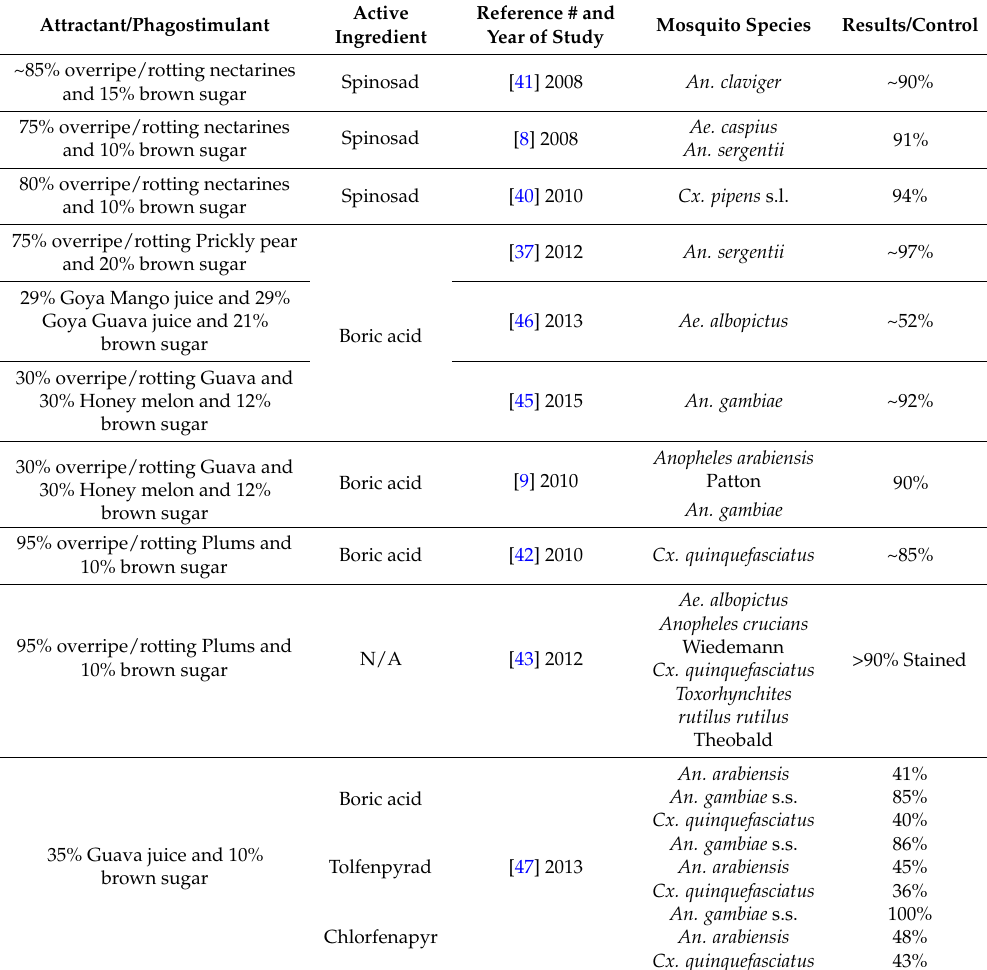
Table 2. Attractive sugar bait studies (ATSB) by attractant and active ingredient. Data represents attractant sources, percentage of attractants and phagostimulants, references for studies with dates, and results of